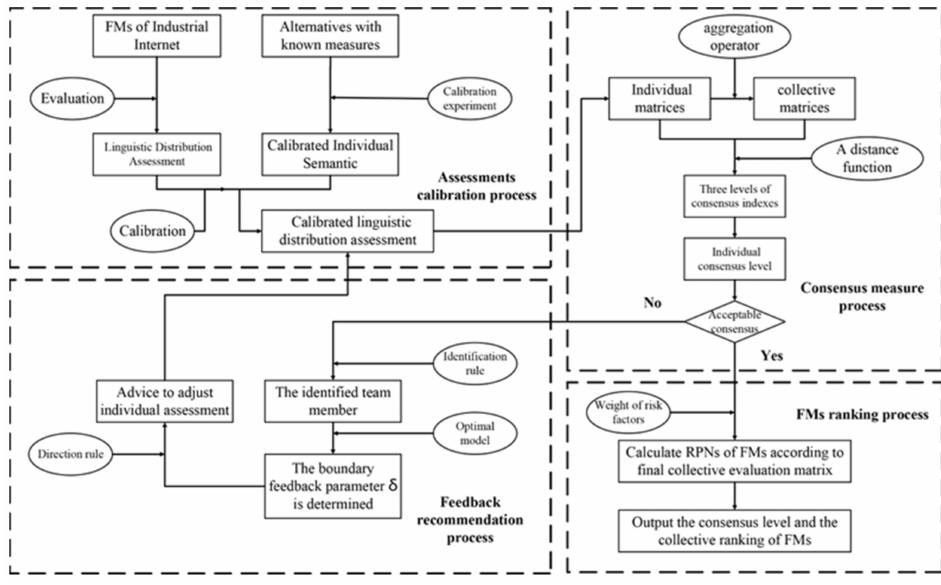
Figure 1. The framework of proposed FMEA method.